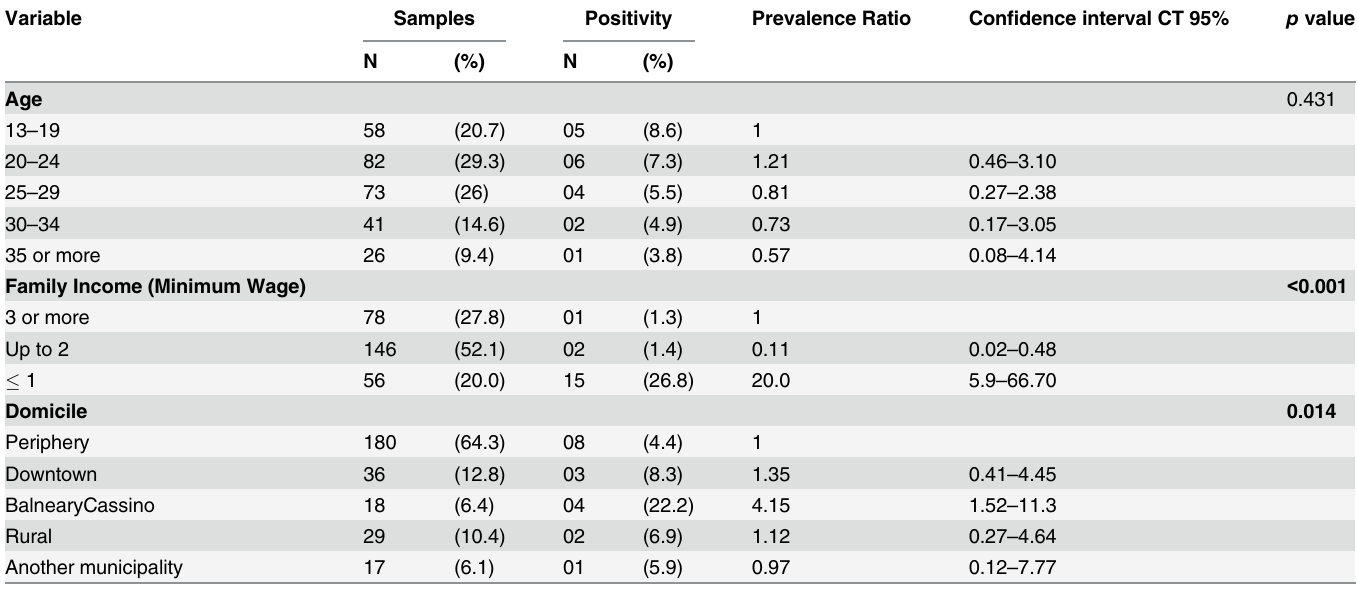
Table 1. The seropositivity (IgG) for Toxocara spp. according to sociodemographic data of the pregnant women attended at the University Hospital in Rio Grande-RS, Brazil from May 2011 to April 2012 (n =